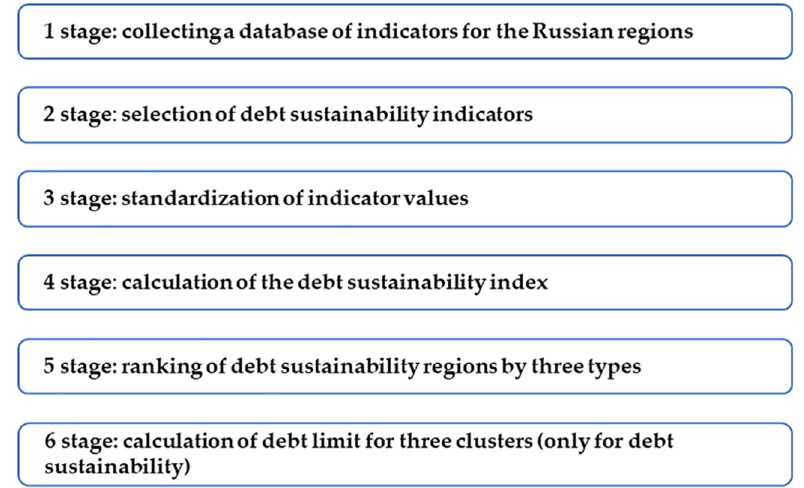
Figure 1. Methodology for assessing the sustainability of the financial